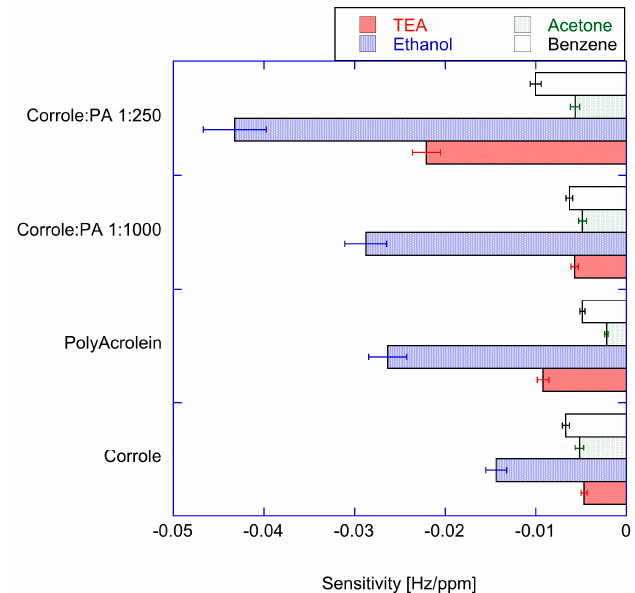
Figure 4. Sensitivity pattern of the four sensors. For the interpretation of these results it is important to consider the properties of the individual constituents. Corrole and polyacrolein show a large sensitivity to ethanol as expected by the Cobalt ion in corrole and electric dipole of acroleyn. TEA has the largest dispersion interaction and then it is better absorbed by the polymer, and π - π interaction may explain the favoured absorption of benzene in corrole. All these characters are preserved and amplified in the PA:corrole sensor with the largest ratio of corrole respect to acrolein. This behavior shows that Corrole:PA enables to get the better of both the individual